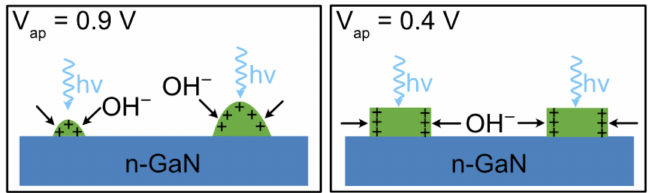
Figure 1. Cross-sectional schematics of the PEC etch process with a coherent light source with two different applied potential (V ap ). The InGaN layer (green) absorbs the light, creating electrons and hole pairs, where the holes collect at the surface. Anisotropy in the distribution of holes creates anisotropic etching that depends on the applied